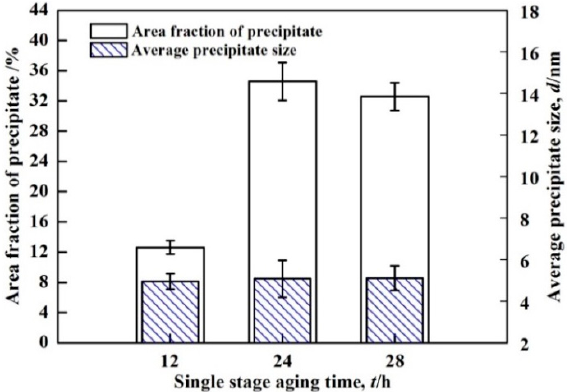
Figure 13. Area fraction of precipitates and average precipitate sizes aged at 130 °C for different times.